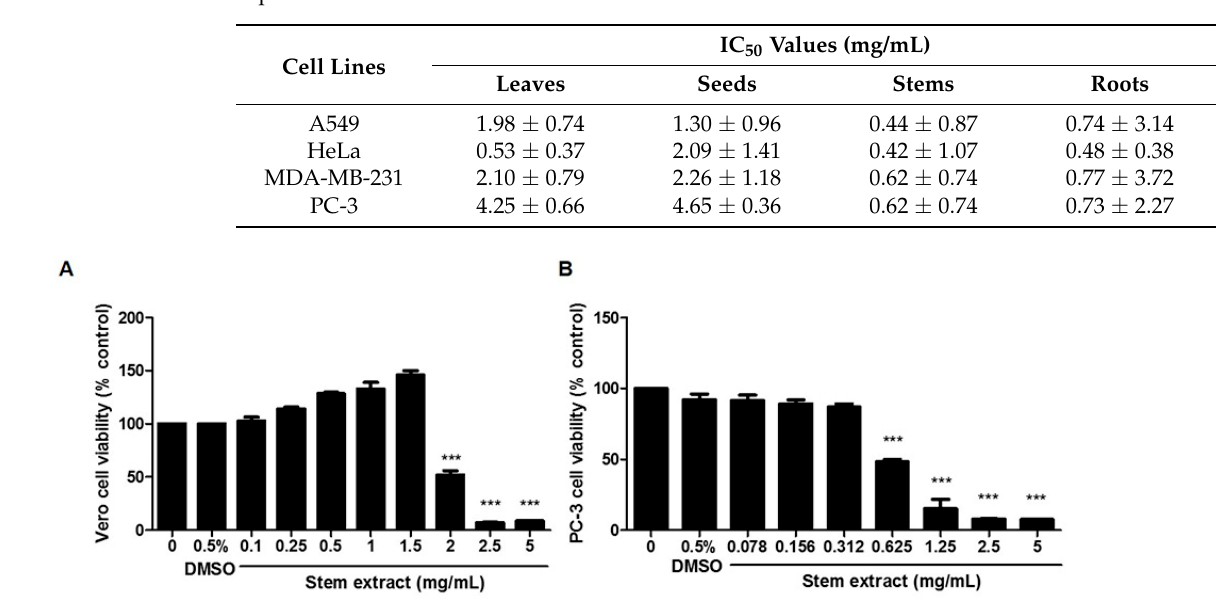
Table 1. The antiproliferative effect of MC extracts were determined by MTT assays. All cells were treated with or without the different parts (leaves, seeds, stems, and roots) of extracts (0–5 mg/mL) for 24 h. Control cells were exposed to vehicle or 0.5% DMSO. The data are offered as the mean of triplicate values ± SEM.